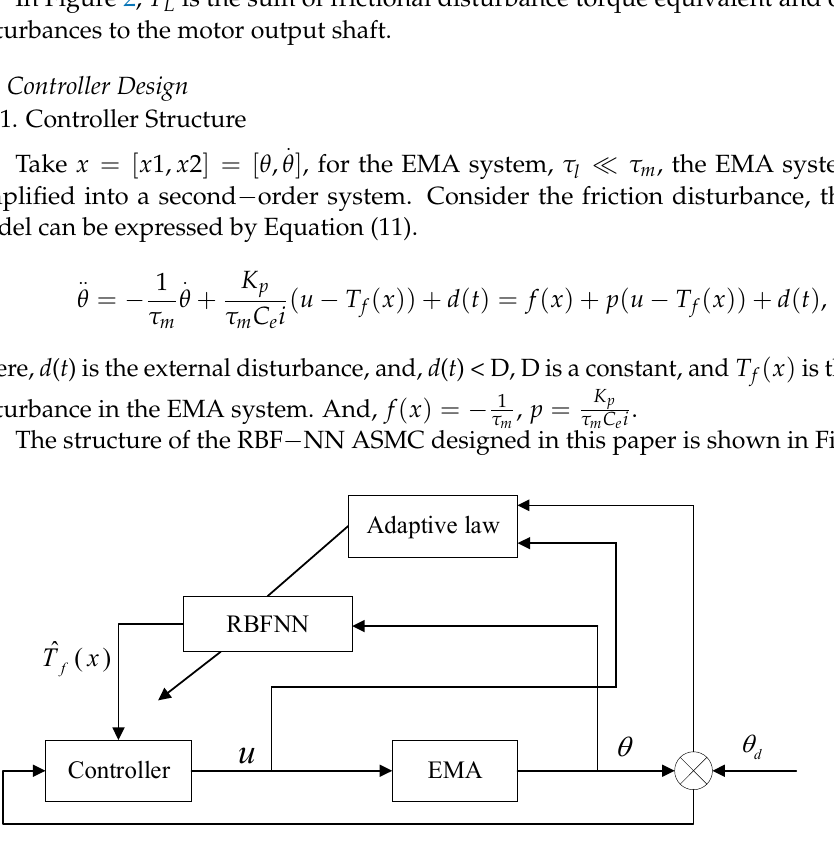
Figure 2. Block diagram of the open − loop transfer function of the EMA system.